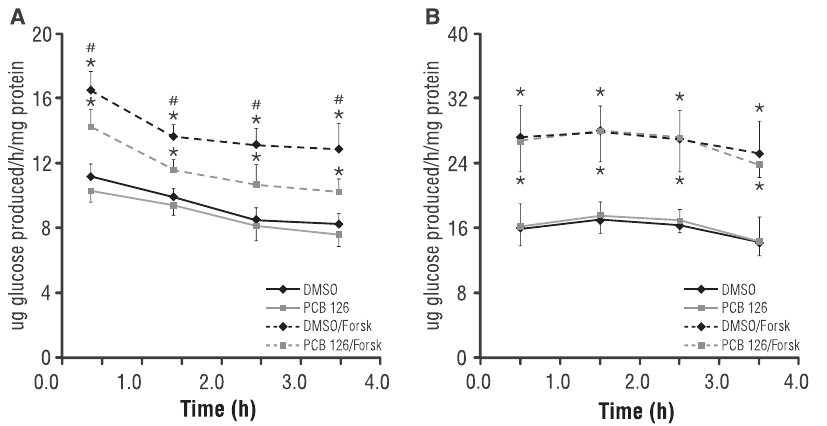
Figure 2. Differential impact of PCB 126 forskolin stimulated hepatic GNG with lactate vs. glycerol. (A) With 10 mM lactate as the carbon source, PCB 126 (100 nM) has no effect on basal GNG, but suppresses forskolin-stimulated glucose output. (B) With 10 mM glycerol as the carbon source, PCB 126 has no effect on either basal or forskolin-stimulated GNG, although total GNG is approximately 2-fold higher for all conditions. *p , 0.05 for forskolin effect relative to respective 2 / + PCB condition, # p , 0.05 for forskolin effect in DMSO vs. PCB condition. All PCB treatments were 16 h in length and forskolin (25 m M) was added at the start of the GNG assay as described in Materials and Methods. Data are average of 3 experiments; error bars are 2 / + SD.